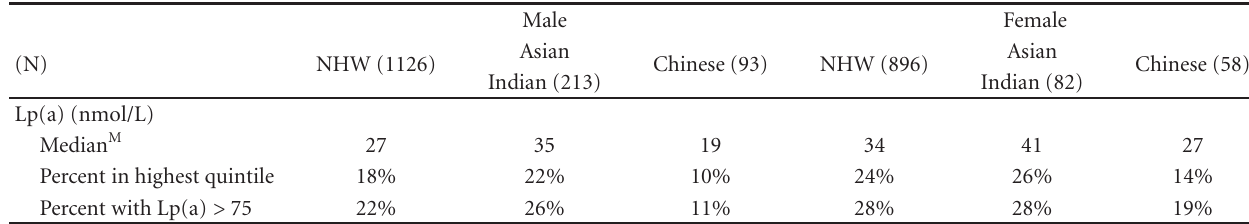
Table 2: Lp(a) summary results by sex and race/ethnicity.